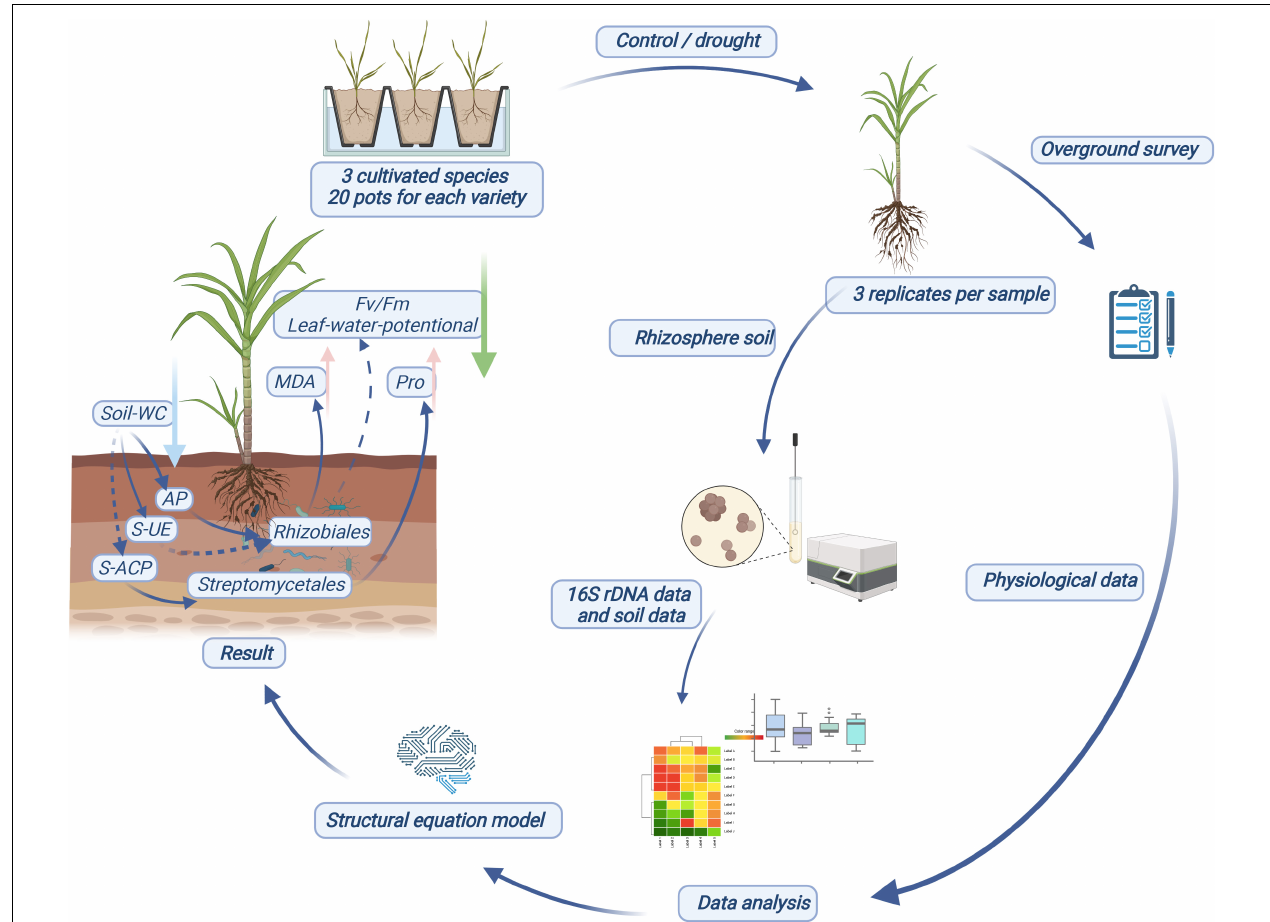
FIGURE 6 | Schematic diagram of experimental design process and